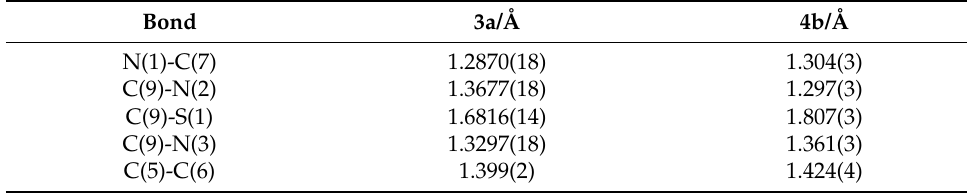
Table 1. Comparison between bonds in compounds 3a and 4b .